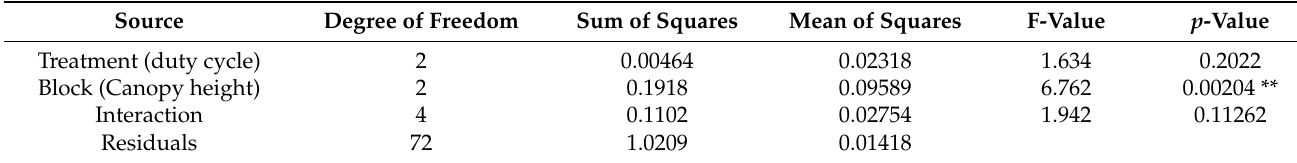
Table 5. ANOVA analysis for drift potential (** p ≤ 0.01).